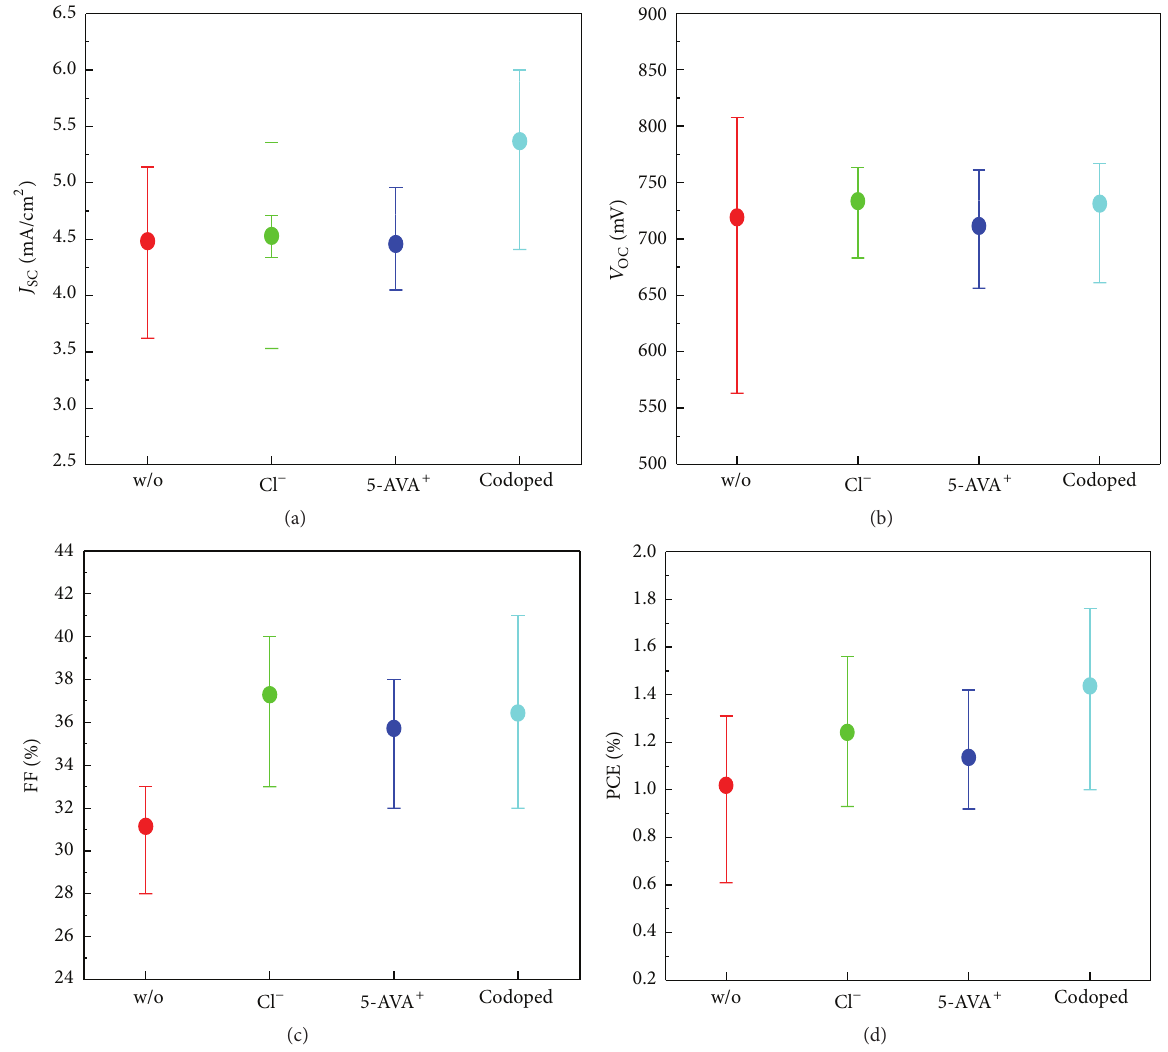
Figure 1: J - V characteristics of single-mesoporous PSCs with/without doping Cl − , 5-AVA + , and codoping: (a) the open-circuit voltage ( 𝑉 OC ), (b) short-circuit current density ( 𝐽 SC ), (c) fill factor (FF), and (d) power conversion efficiency